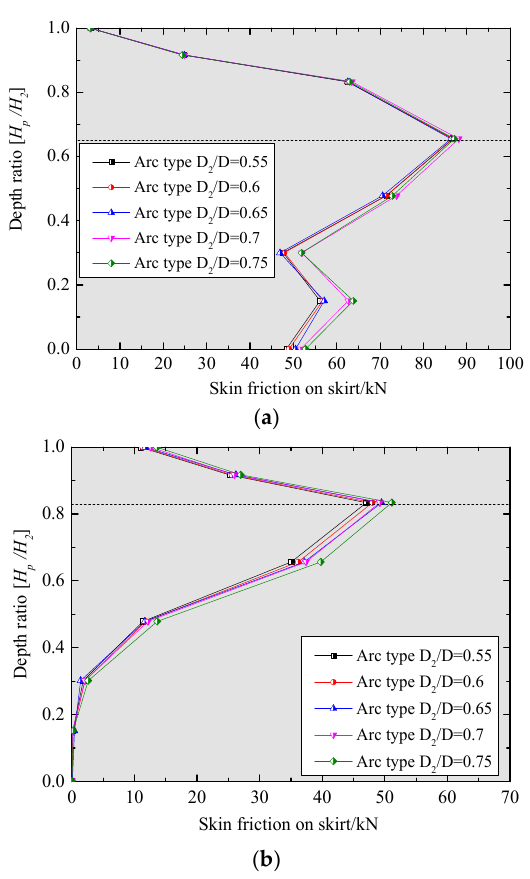
Figure 20. Skin friction on front bucket: ( a ) Outside skirt; ( b ) Inside skirt.